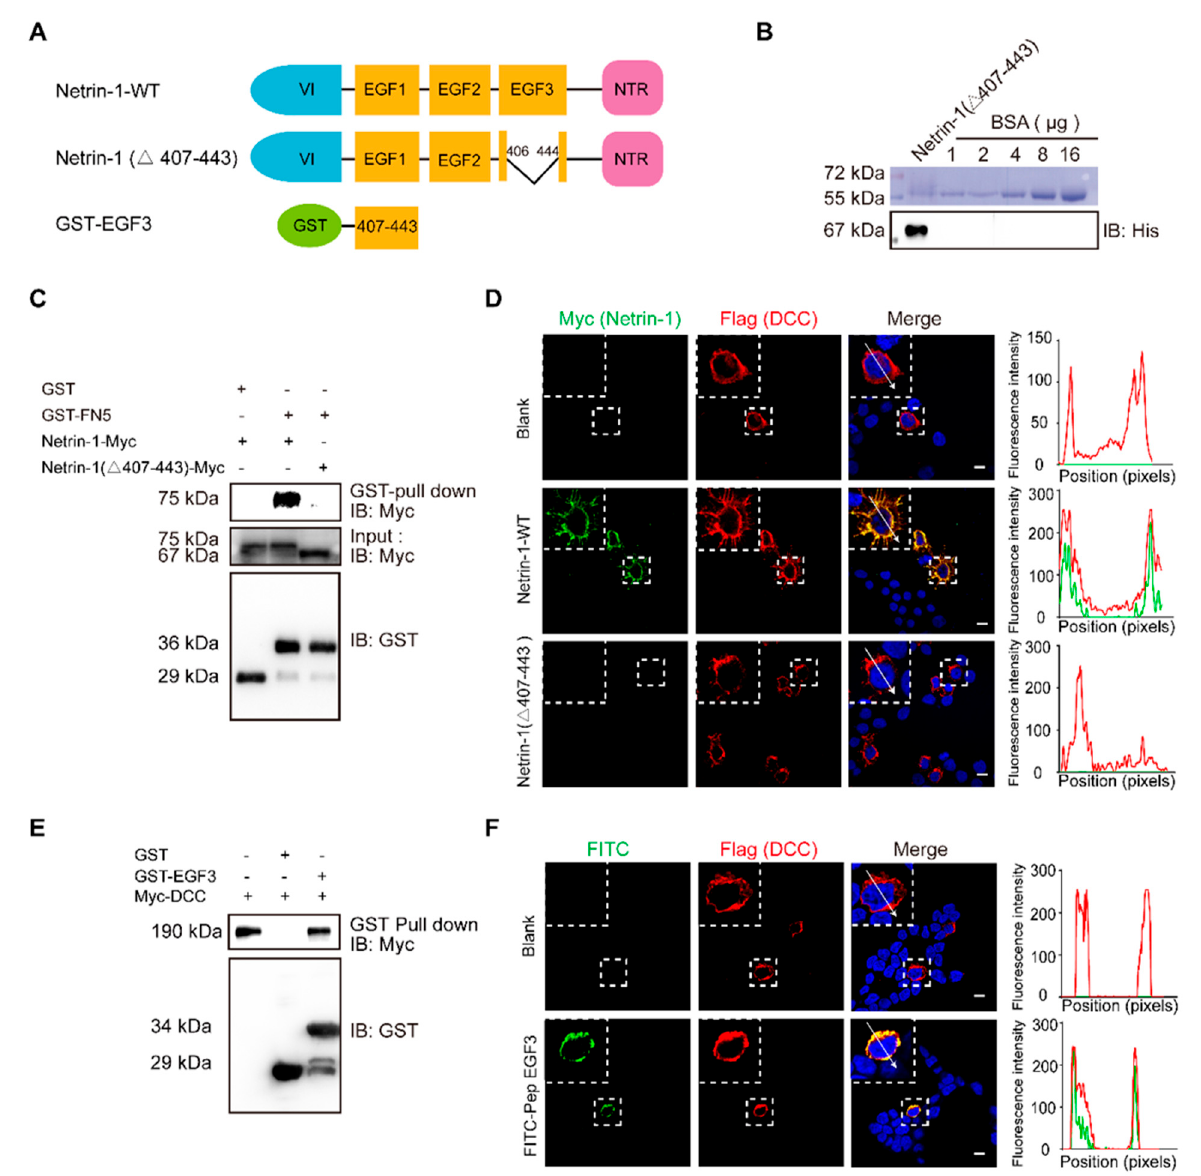
Figure 1. The EGF3 domain of Netrin-1 is the critical region for Netrin-1/DCC interaction. ( A ) Illustrations of Netrin-1 constructs. The Netrin-1 constructs are Netrin-1 full-length, Netrin-1-( ∆ 407–443) and GST-EGF3. ( B ) Purified Netrin-1- ( ∆ 407–443)-Myc/His were quantified through a comparison with the BSA standard curve. ( C ) Immunoblotting of the pull-down fraction by the GST-DCC FN5 domain fusion protein and GST alone. ( D ) Immunofluorescence images of Flag-DCC expressing 293T cells incubated with control medium, Netrin-1-myc/his and Netrin-1-( ∆ 407–443) -Myc/his for 30 min, respectively, and the quantitative analysis. Scale bar, 10 µ m. ( E ) Immunoblotting of the pull-down fraction by the GST-EGF3 fusion protein and GST along. ( F ) Immunofluorescence images of Flag-DCC expressing 293T cells incubated with control medium and FITC labeled Pep EGF3 for 30 min, respectively, and the quantitative analysis. Scale bar, 10 µm.